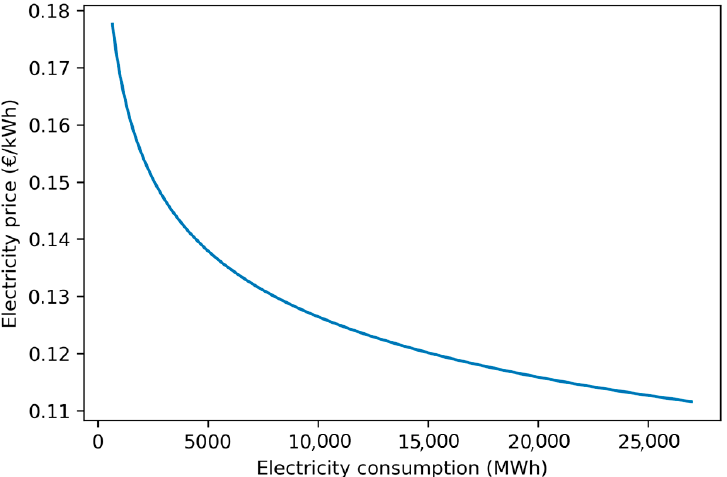
Figure 2. Electricity price trendline (based on 2011–2021 data) for Belgian non-household users in function of consumption [47].